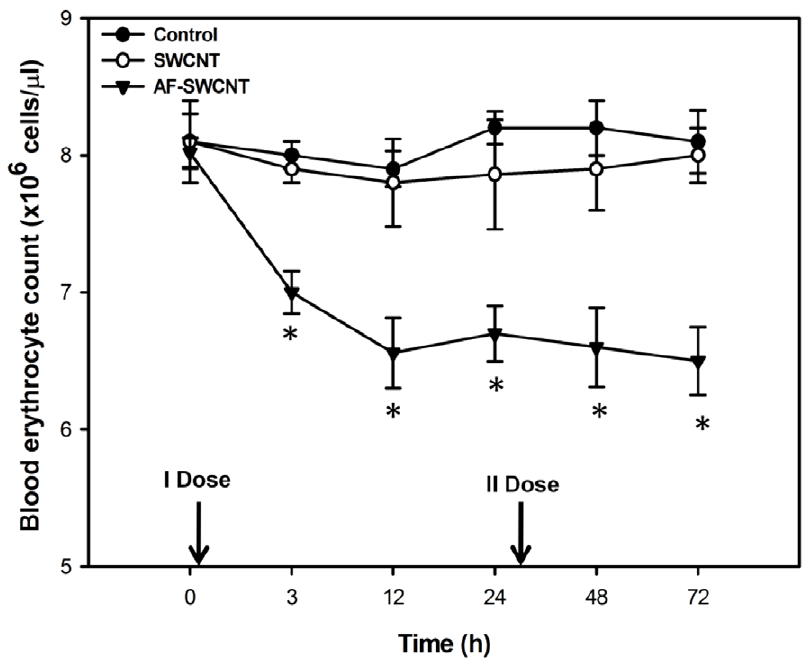
Figure 7. Prolongation of anemia by a second dose of AF-SWCNTs. The experiment was performed as detailed in Figure 5 except that a second dose of SWCNTs and AF-SWCNTs was given 25 h after the first dose. Blood erythrocyte counts were monitored till three days. All data points represent mean 6 SEM of three observations. *p , 0.01 as compared to PBS administered control groups.